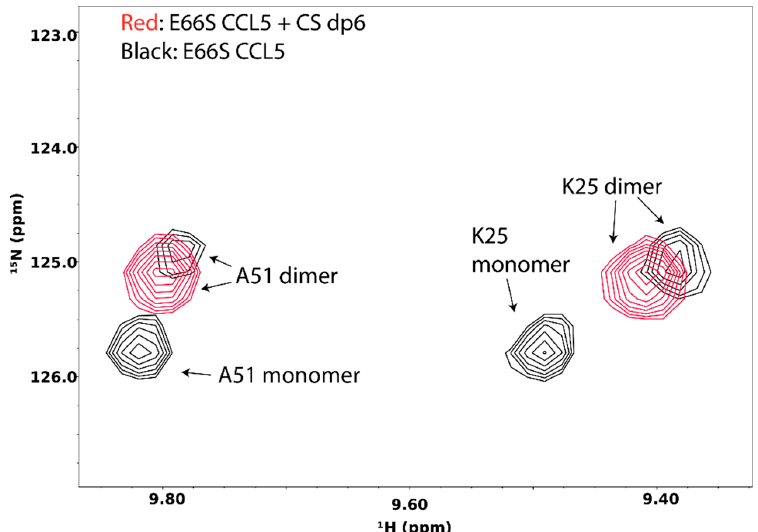
Figure 15. 15 N-HSQC spectra of CCL5 in the presence (red) and absence (black) of chondroitin sulfate hexasaccharide. At 40 °C, CCL5 exists in both dimer and monomer forms. However, addition of chondroitin sulfate hexasaccharide induces the formation of CCL5 dimer, leaving only dimeric CCL5 signals in the 15 N-HSQC spectrum.